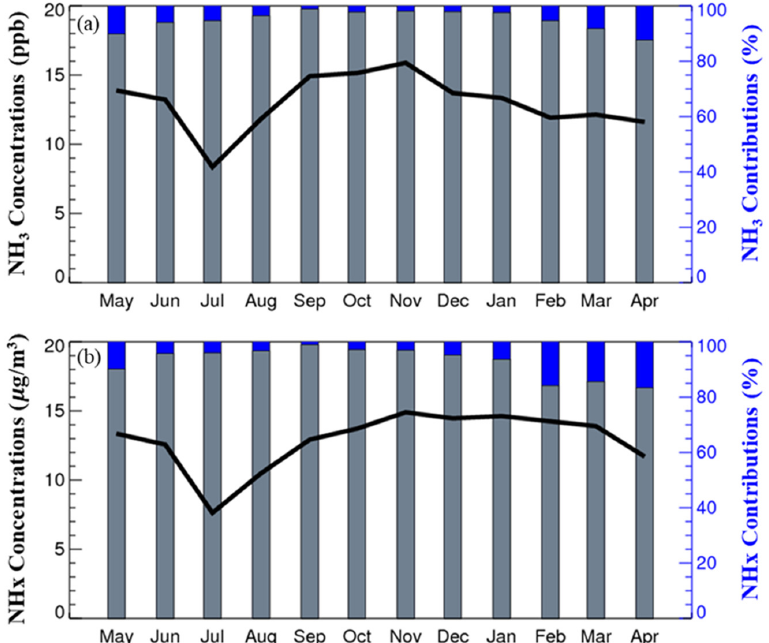
Figure 9. Simulated monthly ( a ) NH 3 and ( b ) total ammonia (NH x ) concentrations (black line) and its relative contributions (blue and gray bars) in Samcheon-dong, Korea. The blue bar represents the contribution of NH 3 and NH x emissions in China and the gray bar represents the contribution from South